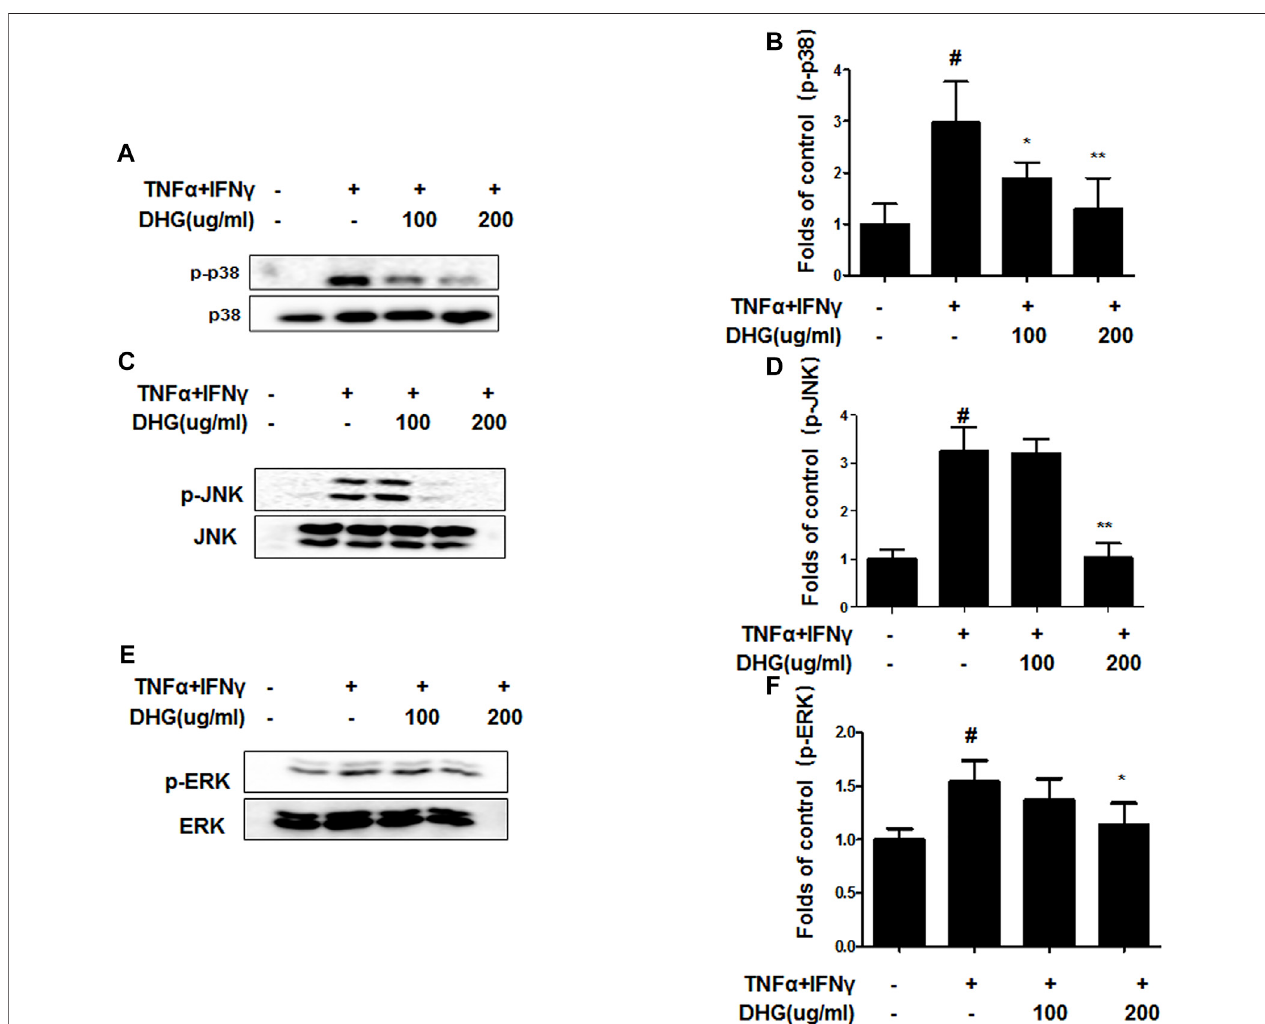
FIGURE 10 | Effects of DHG on p-p38 (A,B) , p-JNK (C,D) , and p-ERK (E,F) MAPK activation in TNF- α /IFN- γ stimulated HaCaT cells. The cells were pre-treated with DHG for 3 h and then stimulated with TNF- α /IFN- γ for 1 h. Total proteins were prepared and were determined by western blotting. The bar graphs represent quantitative densities of the bands. Data are represented as mean ± SD of three independent experiments. * p < 0.05, ** p < 0.01 compared with the TNF- α /IFN- γ - treated group.